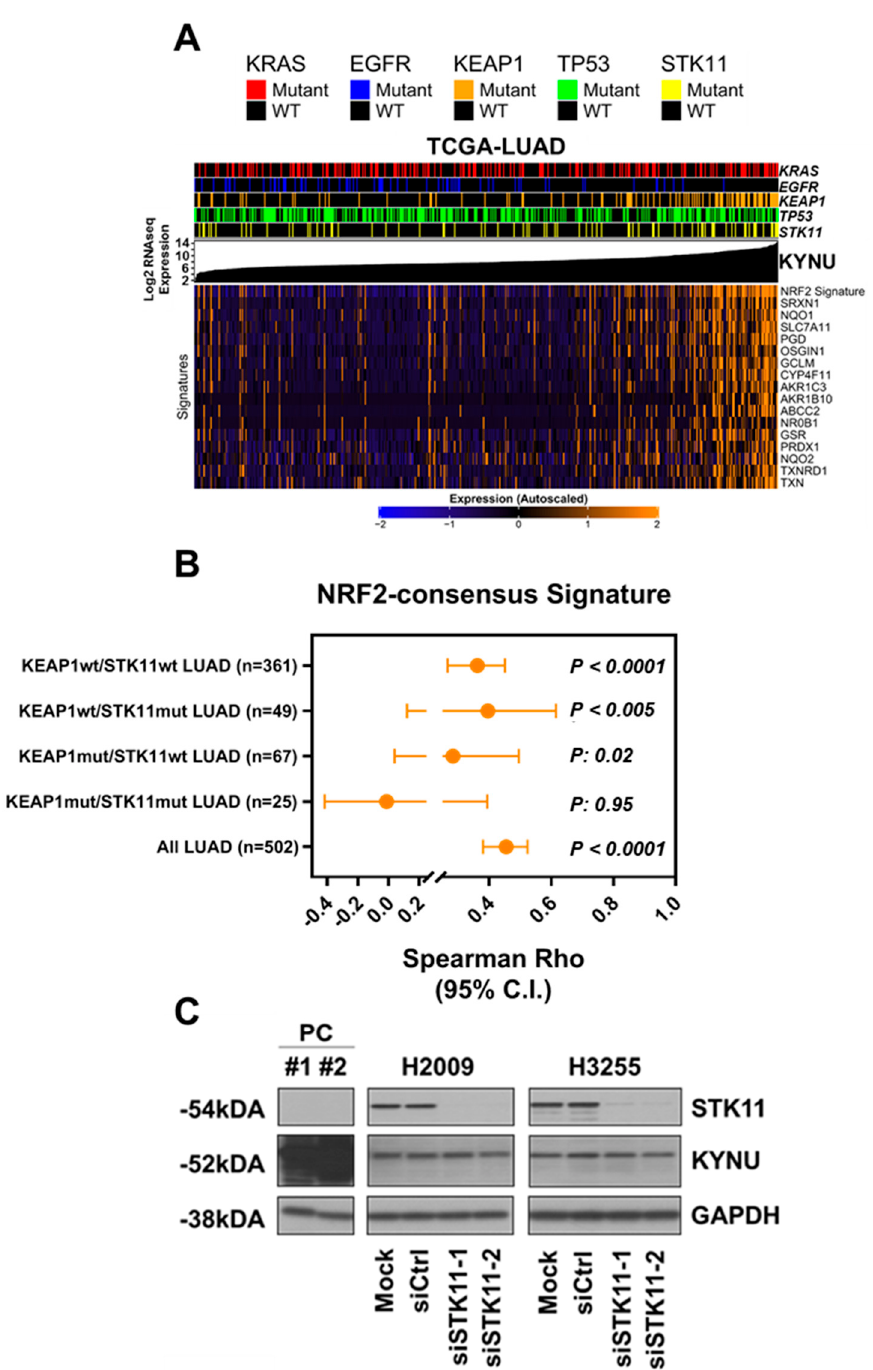
Figure A3. Association between KYNU and NRF2-gene based signatures in TCGA LUAD dataset. ( A ) Heatmap representing gene expression of NRF2-downstream targets including the consensus panel described by Best et al. [13] amongst TCGA LUAD tumors. Columns are ranked (lowest to highest) by KYNU mRNA expression. ( B ) Spearman correlation coefficients (95% confidence interval) between KYNU mRNA expression and the gene-based NRF2 consensus signature described by Best et al. [13] in TCGA-LUAD tumors stratified by presence or absence of STK11 and KEAP1 mutations. ( C ) Immunoblots for KYNU protein expression following siRNA-mediated knockdown of STK11 in KYNU-low STK11 -wild type LUAD cell lines H2009 and H3255. DFCI024 and H2030 lysates were used as positive controls for KYNU protein expression.